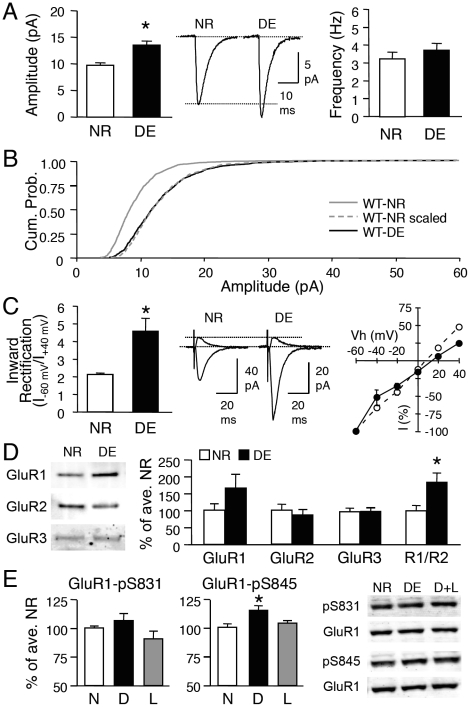
Visual deprivation induces homeostatic changes in excitatory synaptic transmission of layer 2/3 neurons in WT mice.
(A) Left: Two days of DE (P21-P23) significantly increased the average mEPSC amplitude (*: t-test, p<0.001). Middle: Average mEPSC traces from WT-NR and WT-DE mice. Right: No difference in the average mEPSC frequency. (B) Cumulative probability of mEPSC amplitude of WT-DE (black solid line) is shifted to larger values (rightward shift) compared to WT-NR (gray solid line). When mEPSC amplitudes of WT-NR are multiplied by a factor (1.4) to match the average mEPSC amplitude of WT-DE, the cumulative probability curve (WT-NR scaled, gray dotted line) superimposes completely on the WT-DE curve (adjusted by removing the noise cut-off). This suggests that DE multiplicatively scales up mEPSC amplitudes. (C) Left: DE significantly increased the average inward rectification index (I–60 mV/I+40 mV) of evoked AMPAR-EPSC (*: t-test, p<0.02). Middle: Superimposed representative AMPAR-EPSC traces measured at -60 mV and +40 mV for NR and DE conditions. Right: I-V plot of evoked AMPAR-EPSC. Note that the I-V curve is linear in NR mice (open circles) and inward rectifying (black circles) in DE mice. (D) DE increased the GluR1/GluR2 (R1/R2) ratio in isolated PSD fractions from the visual cortex. Comparison of GluR1 (left), GluR2 (2nd from left), and GluR3 (3rd from left) levels and the R1/R2 ratio (rightmost) at the PSD of NR and DE. Left panel: Example immunoblots probed with antibody against GluR1 C-terminal, GluR2 N-terminal, and GluR3. *: t-test, p<0.02. (E) Left: No significant change in GluR1-S831 phosphorylation across NR (N), DE (D) and D+L (L) groups. Middle: DE (D) significantly increased GluR1-S845 phosphorylation compared to NR (N) and D+L (L). Right: Sample immunoblots probed with phospho-specific antibody to GluR1-S831 (pS831) and GluR1-S845 (pS845). Each blot was simultaneously probed with a GluR1 C-terminal antibody (GluR1). *: Significantly different from NR and D+L at p<0.001 with Fisher's PLSD posthoc test following a one-factor ANOVA.